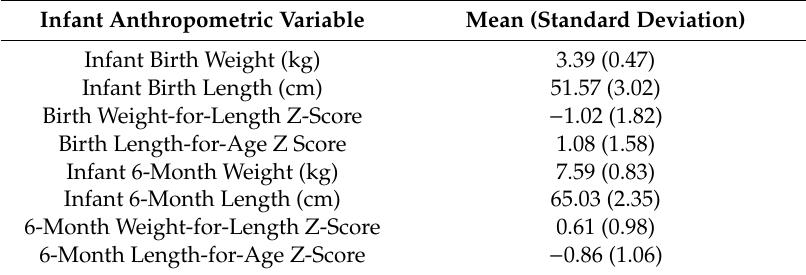
Table 3. Infant Anthropometric Variable Descriptive